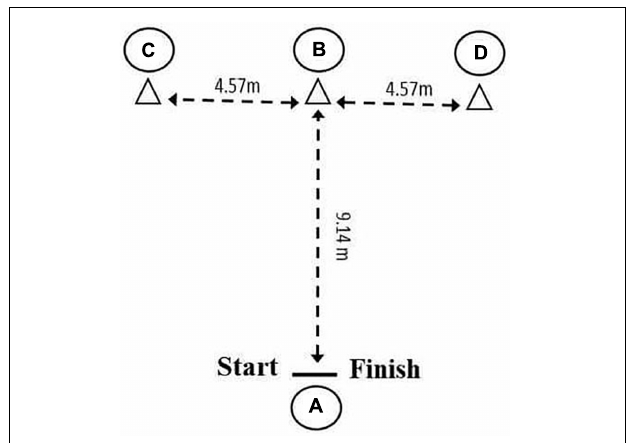
FIGURE 1 | T -test